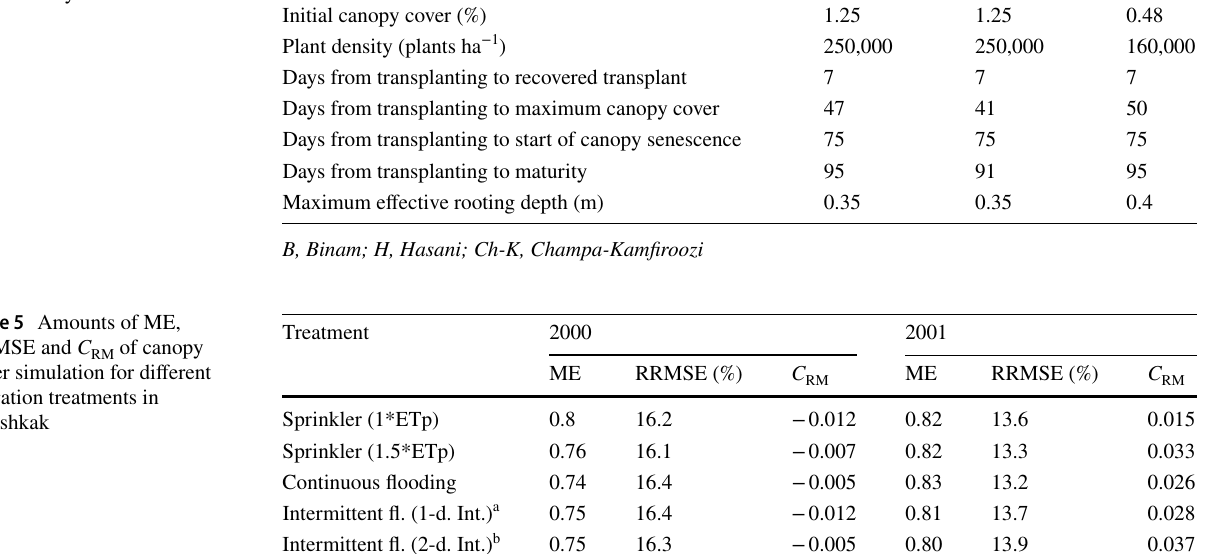
Table 4 Amounts of the AquaCrop model calibrated parameters to simulate rice growth and yield